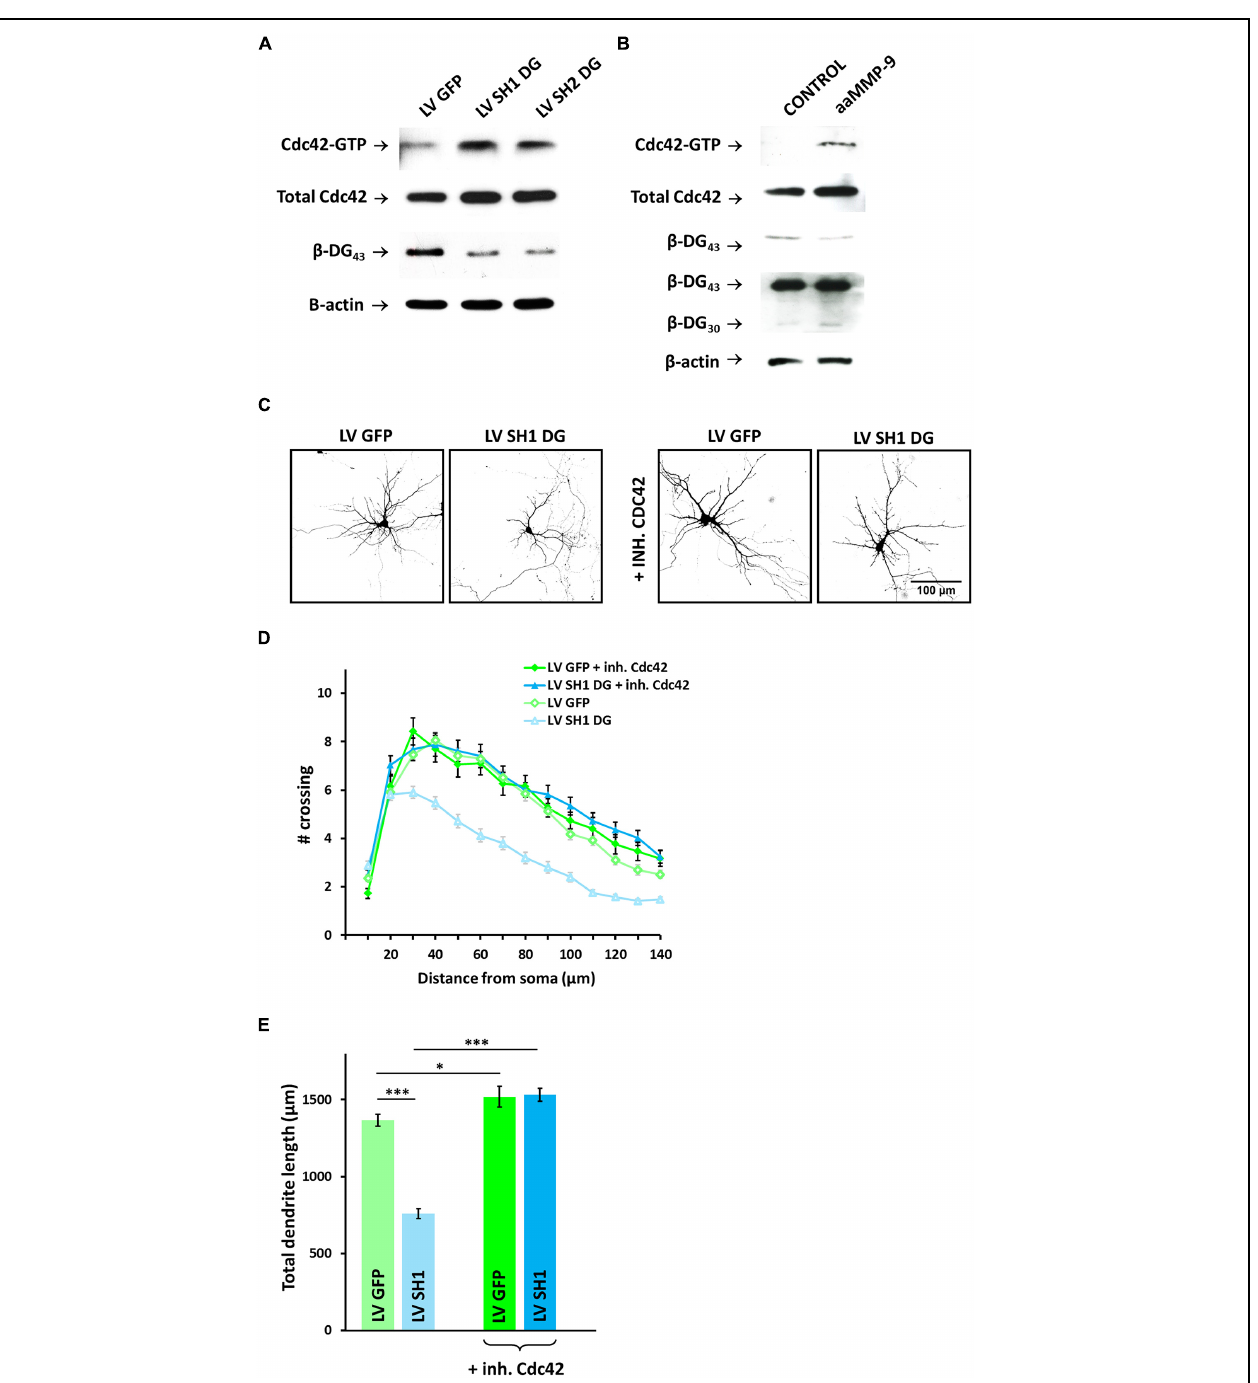
RFP-coding vector to visualize the exact morphology. (D) Sholl analysis of hippocampal neurons treated as indicated (LV GFP, n cell = 85; LV SH1 DG, n cell = 87; LV GFP + Cdc42 inhibitor, n cell = 28; LV SH1 DG + Cdc42 inhibitor, n cell = 51). At distances of 20–140 μ m from the cell body, the differences between DG-deficient neurons that were treated with the Cdc42 inhibitor and DG-deficient neurons that were not treated with the Cdc42 inhibitor were statistically significant ( p < 0.001). (E) Total dendritic length for neurons treated as indicated. Three independent experiments were performed. The data are expressed as mean ± SEM. ∗ p < 0.05, ∗∗∗ p < 0.001 (Student’s t